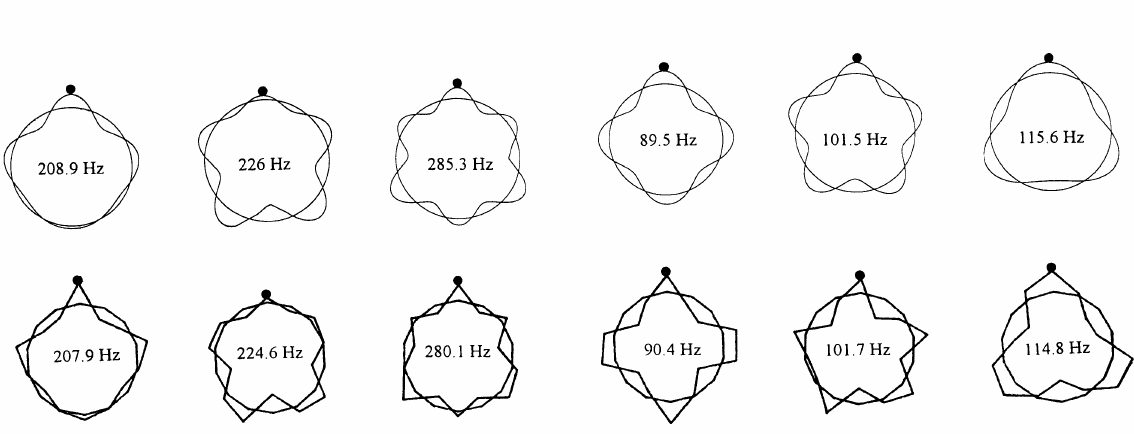
FIGURE 4 First three mode shapes of the empty shell obtained by roots of the frequency equation, Eq. (30). Above: computed mode shapes. Below: measured mode shapes.